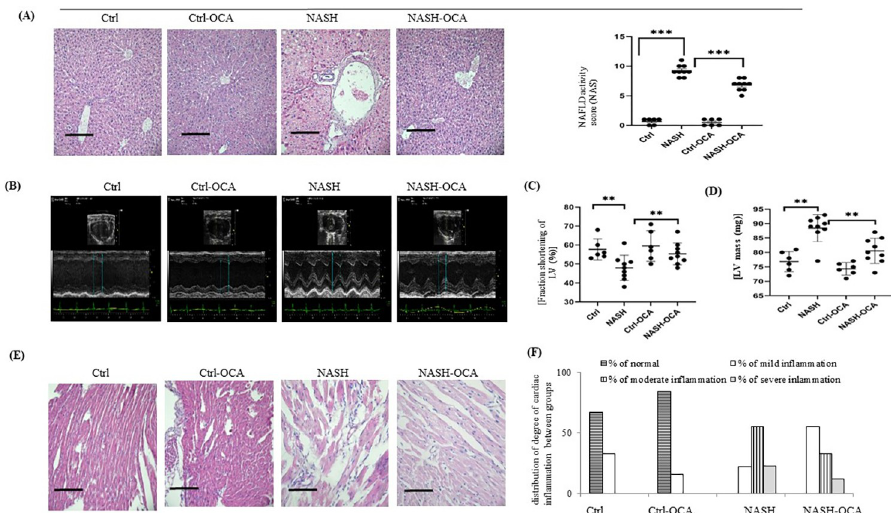
Fig 1. Chronic OCA treatment suppresses NASH-related cardiac dysfunction. (A) hepatic NAFLD score . (B-C) fraction of shortening (FS). (D) LV mass. (E-F) cardiac H&E staining for inflammation. 20x, Scale bar: 100 μ m; �� , ��� : p < 0.01 or < 0.001 vs . Ctrl or NASH group. FS=(LVDd-LVDs)/LVDd × 100%; LVDd: LV diastolic dimension; LVDs: lLV systolic dimension; LVEF=(LVEDV-LVESV)/LVEDV × 100% (LVEDV, LV end-diastolic volume; LVESV, LV end- systolic volume). The degree of cardiac inflammation was classified as mild (mononuclear cell infiltration < 25% of the tissue), moderate (25%–50% of the tissue), or severe ( >